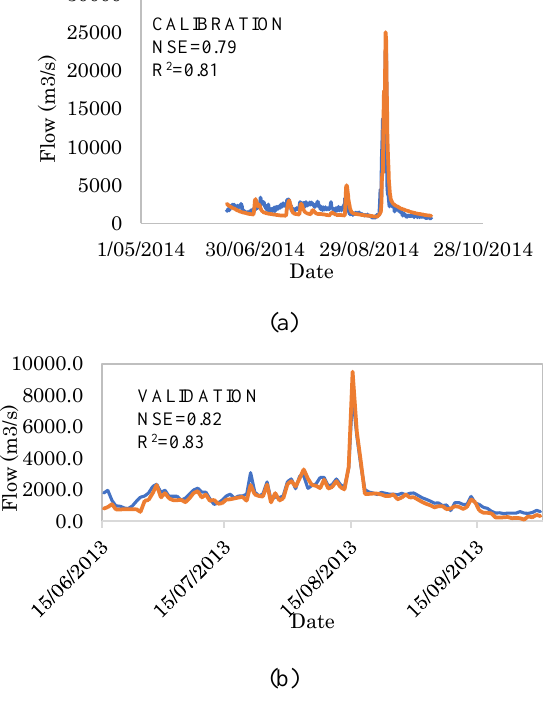
Fig. 14. (a) Calibration (for the monsoon period of year 2014) and (b) Validation results (for the monsoon period of year 2013) in Maralla